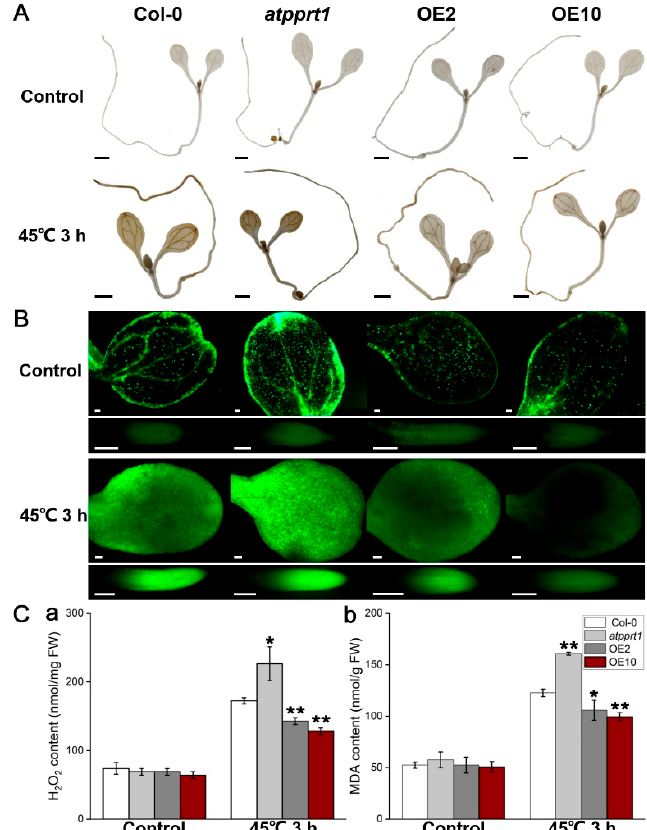
Figure 4. AtPPRT1 reduces tissue damage caused by heat stress. ( A ) DAB-staining assay of 7-day-old seedlings of Col-0, atpprt1 , OE2 and OE10 after heat stress. Scale bar: 1 mm; ( B ) detection of ROS in 7-day-old seedlings of different genotypes by using H 2 DCFDA. Seedlings from Col-0, atpprt1 , OE2 and OE10 were exposed to 45 °C for 3 h. Fluorescence of ROS (green) was imaged in cotyledon and root cells, and the images were collected after 15 min; ( C ) content of ( a ) H 2 O 2 and ( b ) MDA in Col-0, atpprt1 , OE2 and OE10 before and after heat stress. Error bars represent ± SD ( n = 3, * p < 0.05, ** p < 0.01, t - test).